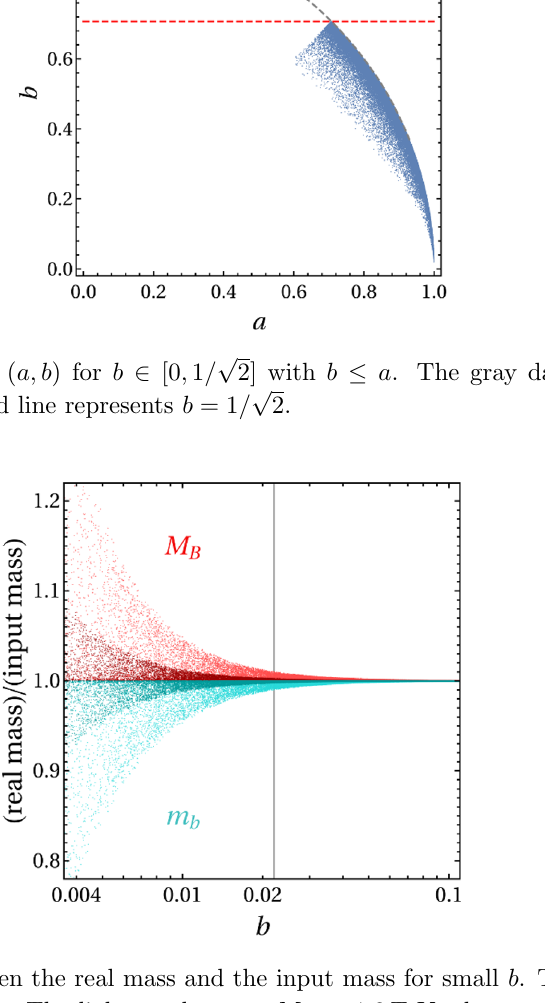
Figure 2 . The ratio between the real mass and the input mass for small b . The gray vertical line marks the left cut in (7.21). The lighter colors use M B = 1 : 3 TeV whereas the darker colors use M B = 2 : 6